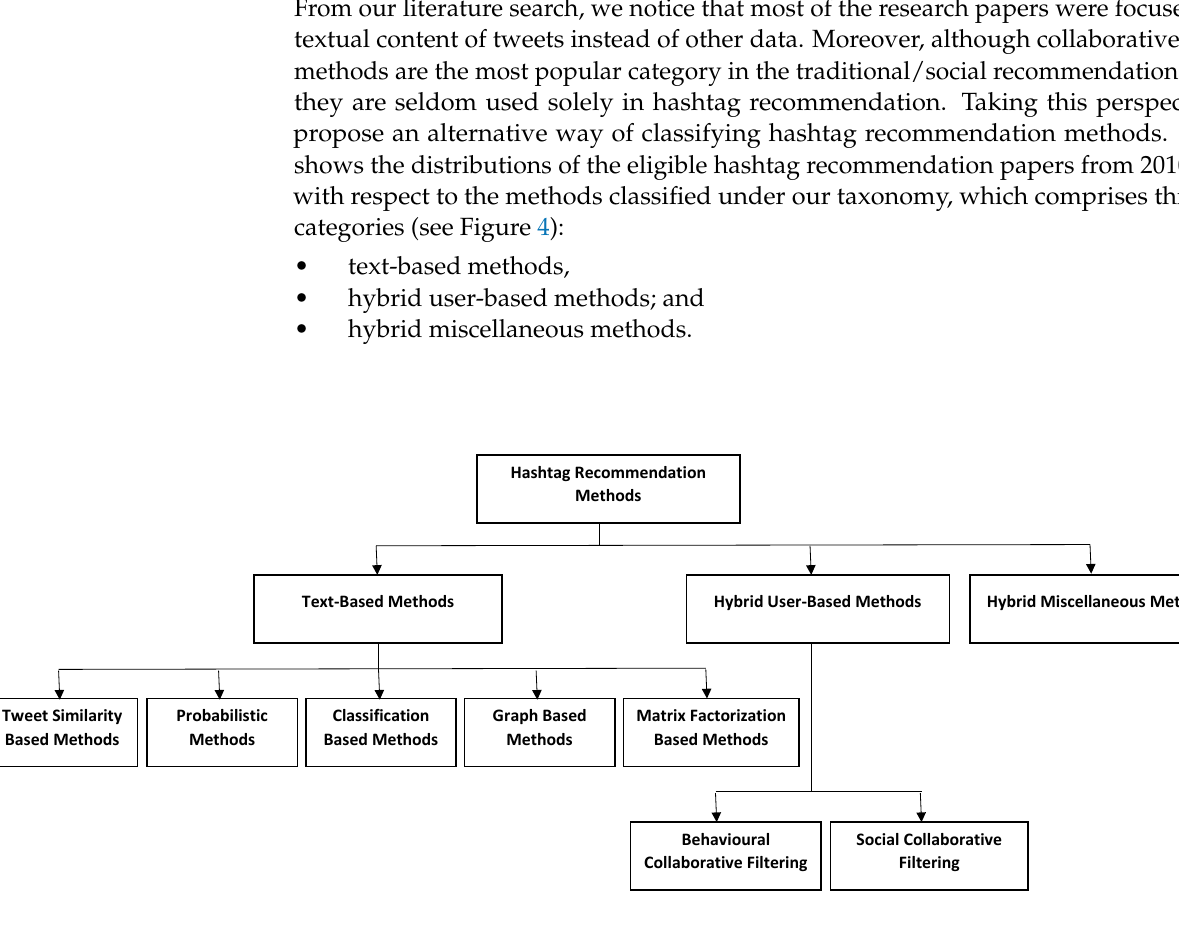
Figure 4. Our proposed taxonomy of the hashtag recommendation